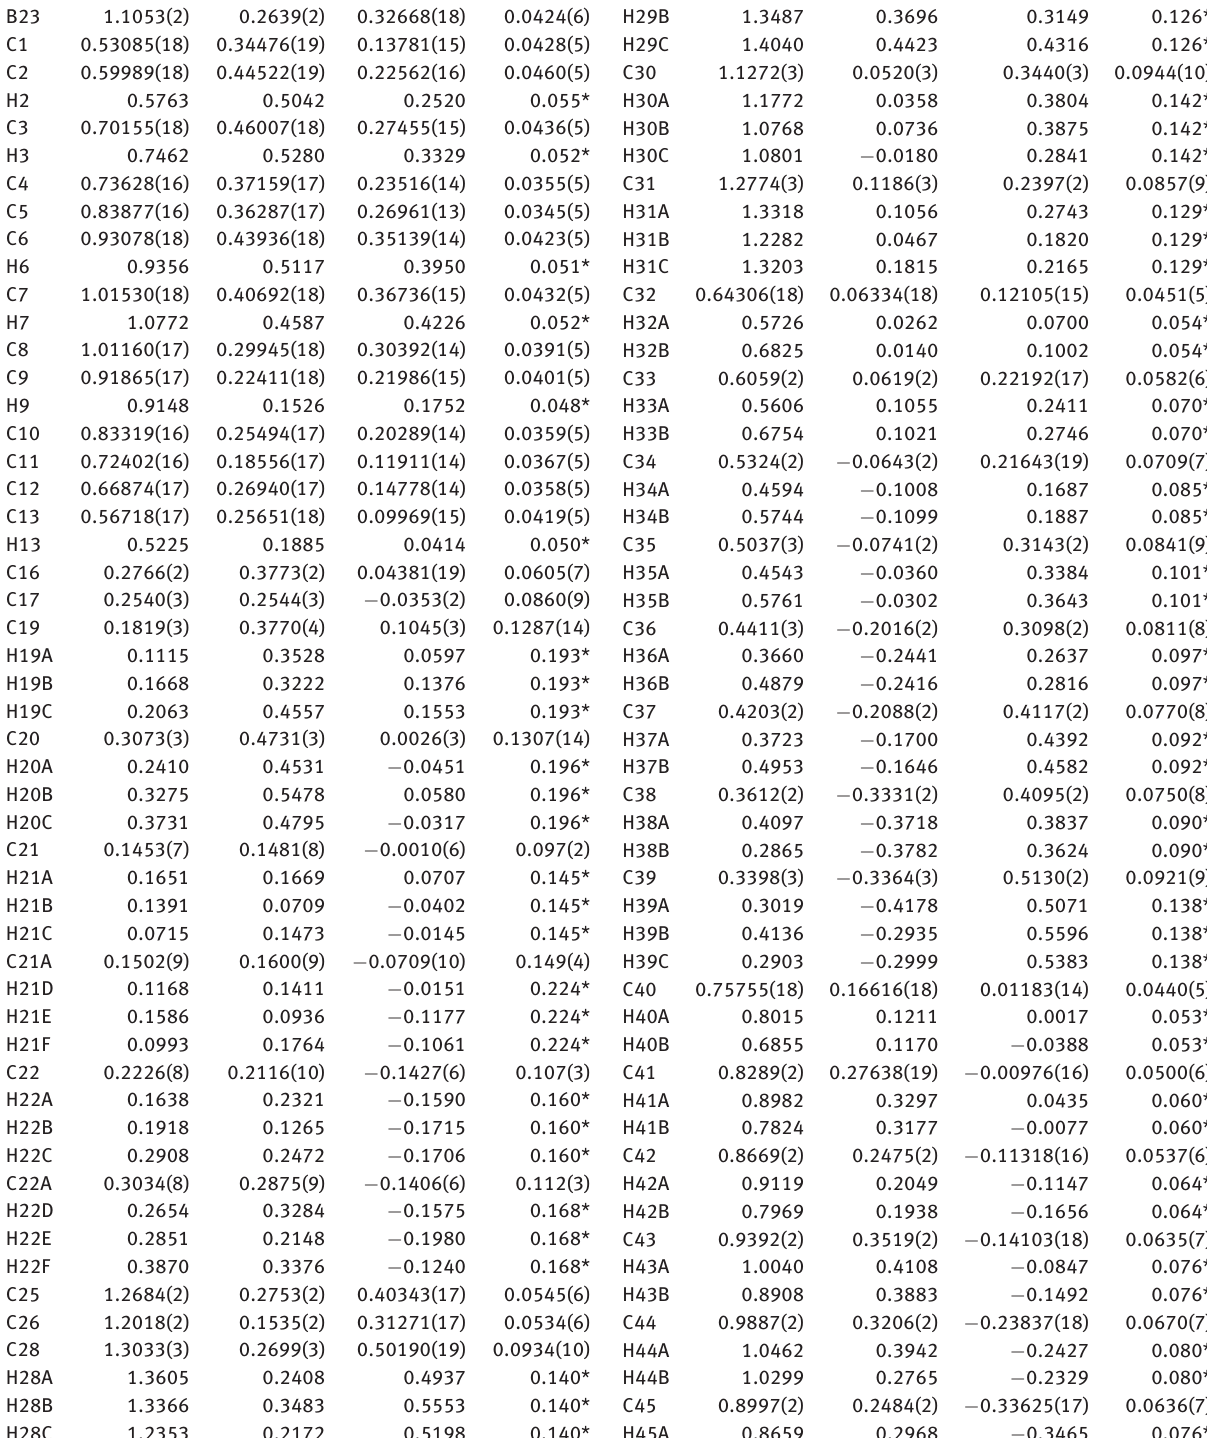
Table 2: Fractional atomic coordinates and isotropic or equivalent isotropic displacement parameters (Å 2